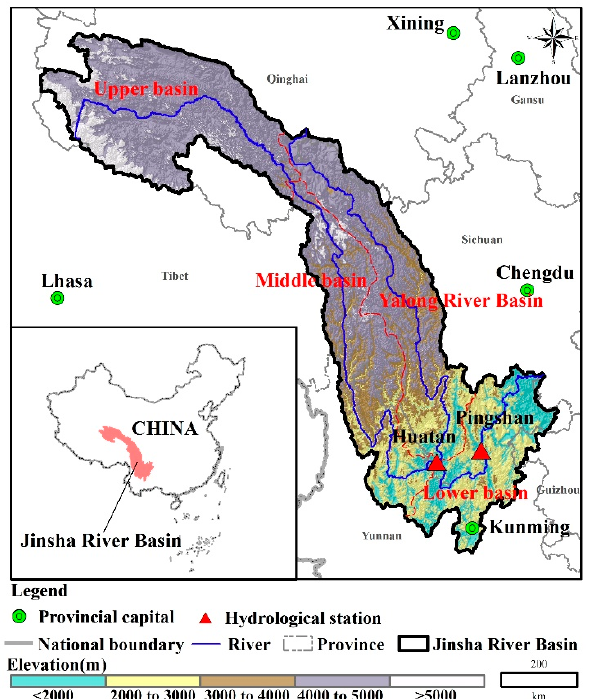
Figure 1. The location of the Jinsha River Basin (JRB).